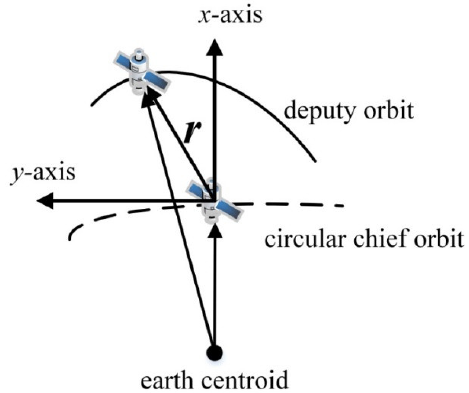
y -axis (tangential unit vector) directed so that a right-handed Cartesian reference frame is formed.